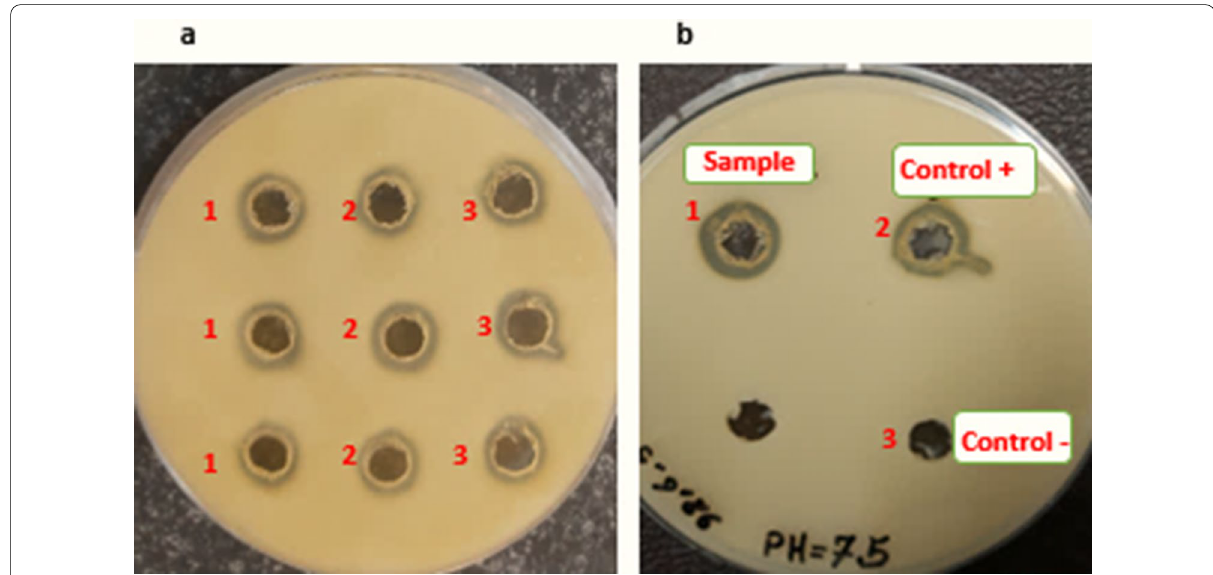
Fig. 4 Radial caseinolytic assay for SAK activity measurement on 5% skim milk-agar plate. a shows the expression of SAK in the dicistronic SILEX system at optimized conditions for three clones (wells 1, 2, and 3 are replicates). b shows the positive and negative control for SAK activity [well 2: commercial SAK with plasminogen (As the positive control), and well 3: Commercial SAK without plasminogen (As the negative